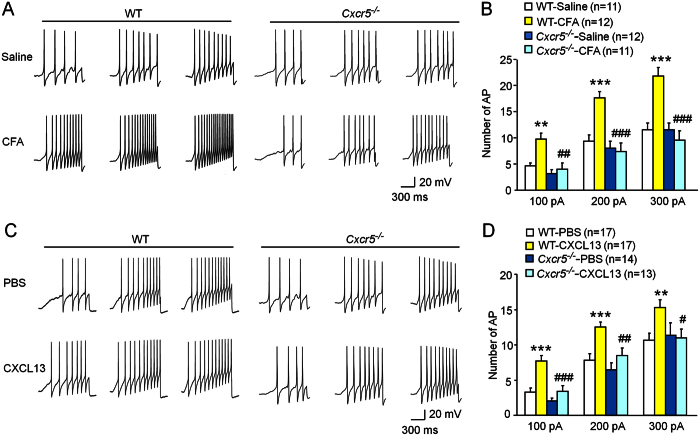
Cxcr5 deletion reduces neuronal excitability of DRG neurons.(A) Examples of membrane potential responses evoked by 1000 ms ramp current injection of 100, 200, and 300 pA for neurons from saline-and CFA-treated wild type (WT) or Cxcr5−/− mice. (B) Histogram shows an increase in numbers of action potential (AP) of DRG neurons from CFA-treated WT mice. Two-way repeated measures ANOVA (Treatment, F3,84 = 15.433, P < 0.001; Current, F2,84 = 123.976, P < 0.001; Interaction, F6,84 = 3.811, P < 0.05). **P < 0.01, ***P < 0.001, compared to WT-saline. ##P < 0.01, ###P < 0.001, compared to WT-CFA, post hoc Bonferroni test. (C) Examples of membrane potential responses evoked by 1000 ms current injection of 100, 200, and 300 pA for the PBS and CXCL13-treated neurons from WT or Cxcr5−/− mice. (D) Histogram shows an increase in numbers of AP of DRG neurons from WT mice after CXCL13 treatment. Two-way repeated measures ANOVA (Treatment, F3,114 = 8.564, P < 0.001; Current, F2,114 = 161.529, P < 0.001; Interaction, F6,114 = 0.873, P > 0.05). **P < 0.01, ***P < 0.001, compared to WT-PBS. #P < 0.05, ##P < 0.01, ###P < 0.001, compared to WT-CXCL13, post hoc Bonferroni test.